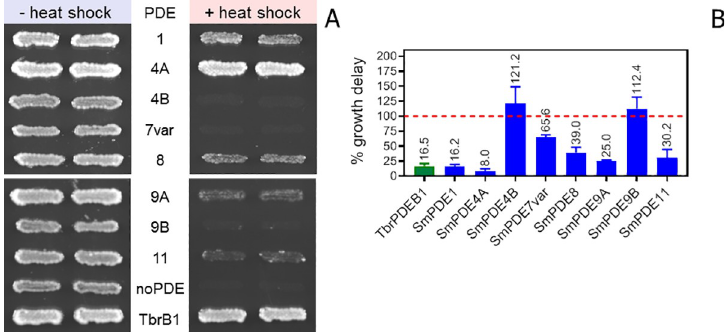
Fig 7. Complementation of temperature sensitivity by SmPDEs. A) Temperature sensitivity of the pde1/ 2 deletion strain PP5 is complemented to various extents by SmPDE1, SmPDE4A, SmPDE8, SmPDE9A and SmPDE11, respectively. PP5 transformed with TbrPDEB1 was taken along as positive control. Duplicate patches of recombinant yeast strains were subjected to heat shock (55˚C for 15 min) or control conditions (30 o C) and were then grown at 30˚C for 1 day. (B) Heat shock complementation in liquid culture. Growth of pde1/2 deletions strain (PM943) expressing SmPDEs was analyzed after exposure to an increased temperature (4 min, 52 o C) or in control condition. Growth (OD600) was examined over 72 h. The resulting growth curves were analyzed for onset of the exponential phase. Comparison of the growth curves of cultures exposed to heat shock and control conditions indicate that SmPDE4B are unable to complement the phenotype (a delay in onset of exponential growth compared to the control, set at 100% (red dotted line). In this assay, TbrPDEB1 (positive control (in green)), SmPDE1, SmPDE4A, SmPDE8, SmPDE9A and SmPDE11 and SmPDE7var display a faster onset of the exponential growth after a high temperature challenge compared to the control